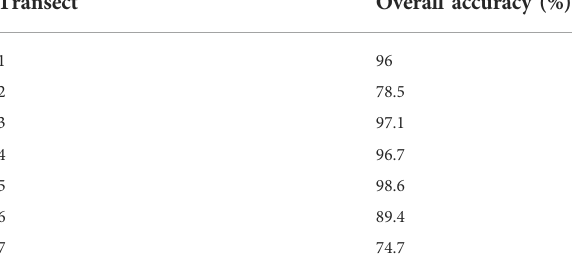
TABLE 2 Overall accuracy of the supervised classi fi cation for segmentation transects 1 – 7, which is the percent agreement between categories in the accuracy points and classi fi ed